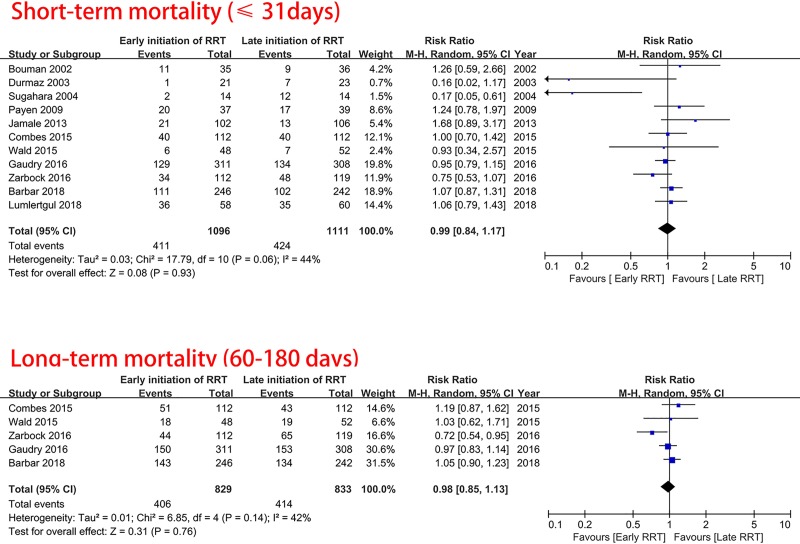
Association of early vs. delay of initiation of renal replacement therapy with short-term and long-term mortality.